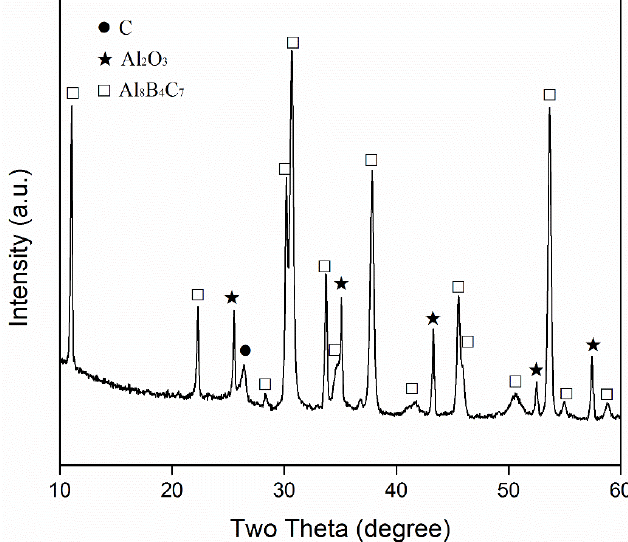
Figure 4. XRD pattern of the Al 4 C 3 -B-C sample after 6 h of firing in 95%NaCl + 5%NaF at 1250 °C.